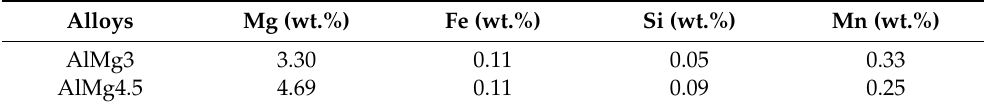
Table 1. Main alloying elements of tested sheets.